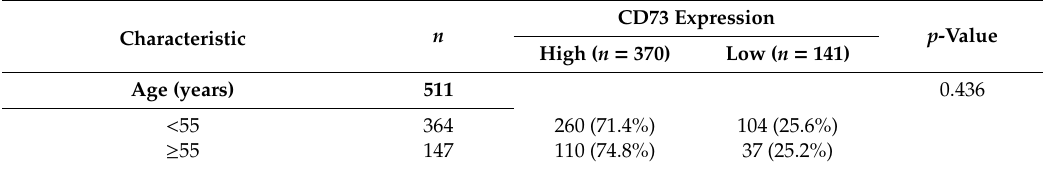
Table 1. Relationship between CD73 expression and clinicopathologic features in 511 patients with papillary thyroid carcinoma.